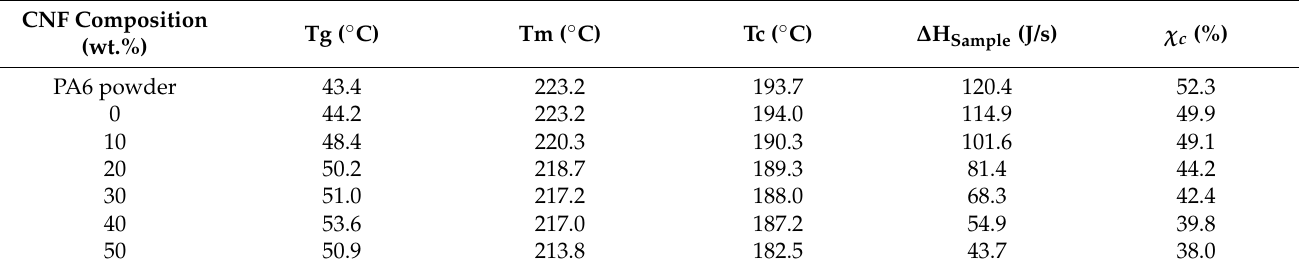
Table 4. Thermal parameters and degree of crystallinity for the PA6 polymer in the plain matrix and in the PA6-CNF nanocomposites.